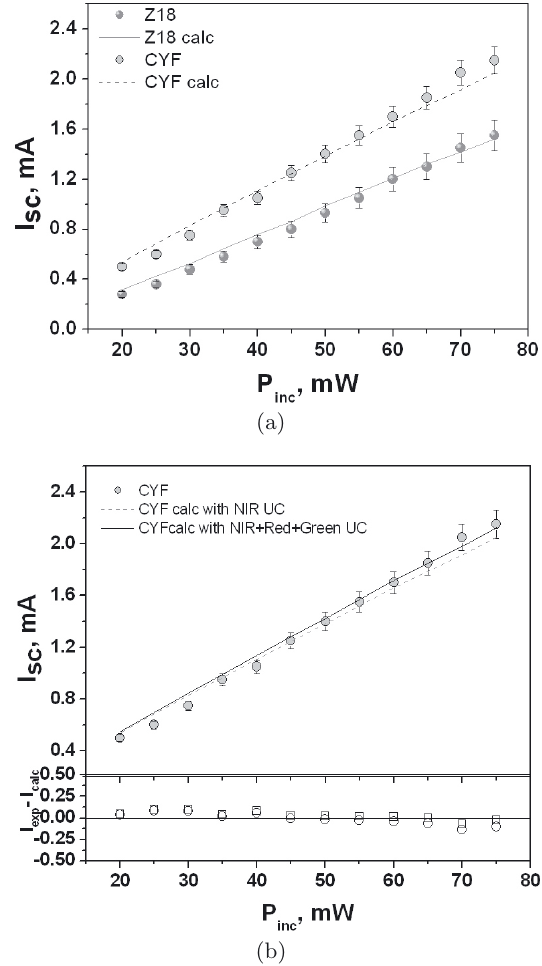
Fig. 7. Photocurrent as a function of the 1.54 μ m excitation power of the upconverter: experimental results and calculated values considering multiple reflections in the upconverter (a) only the upconverted in the NIR is considered in the calcu- lations; (b) all upconverted emissions are considered in the